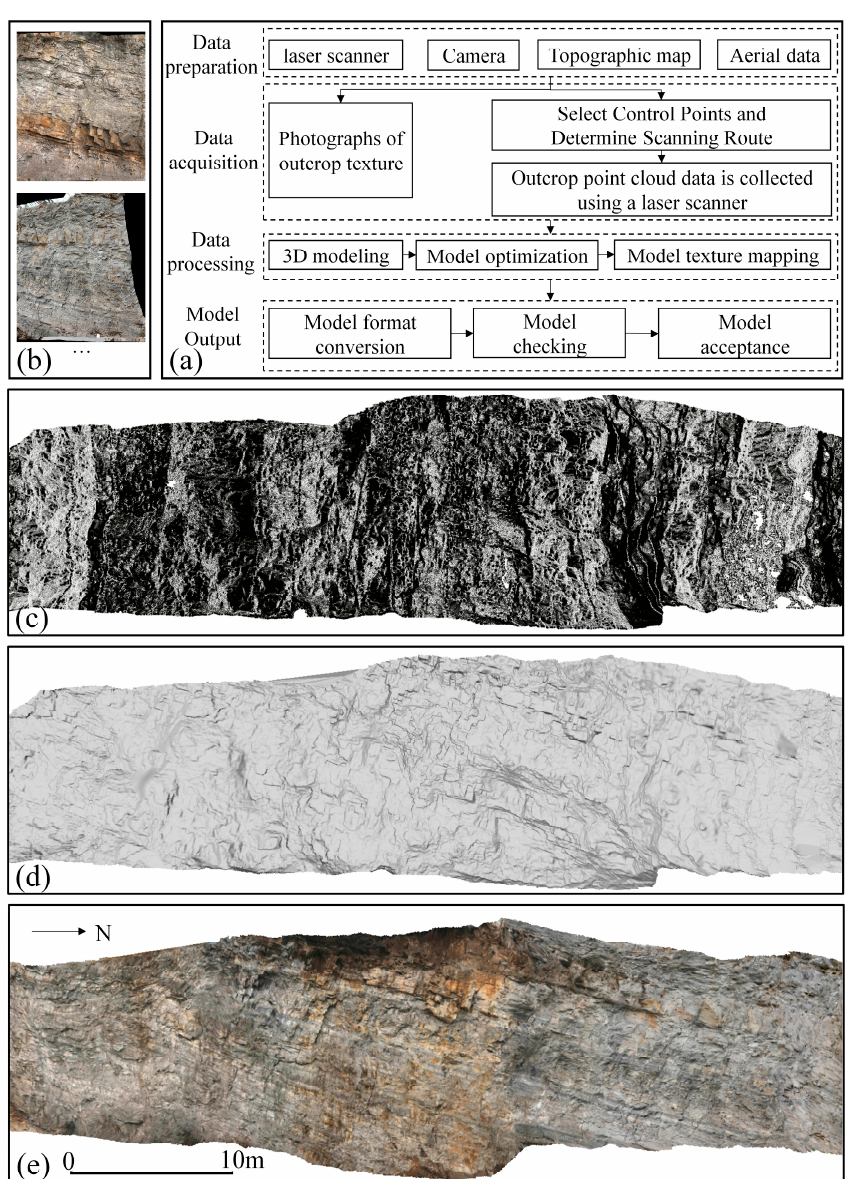
Figure 2. Workflow of DOM creation based on lidar. ( a ) The primary workflow. ( b ) Outcrop high- definition picture data captured using a digital camera. ( c ) 3D point cloud of outcrop collected by lidar. ( d ) 3D digital outcrop mesh model. ( e ) 3D digital outcrop texture